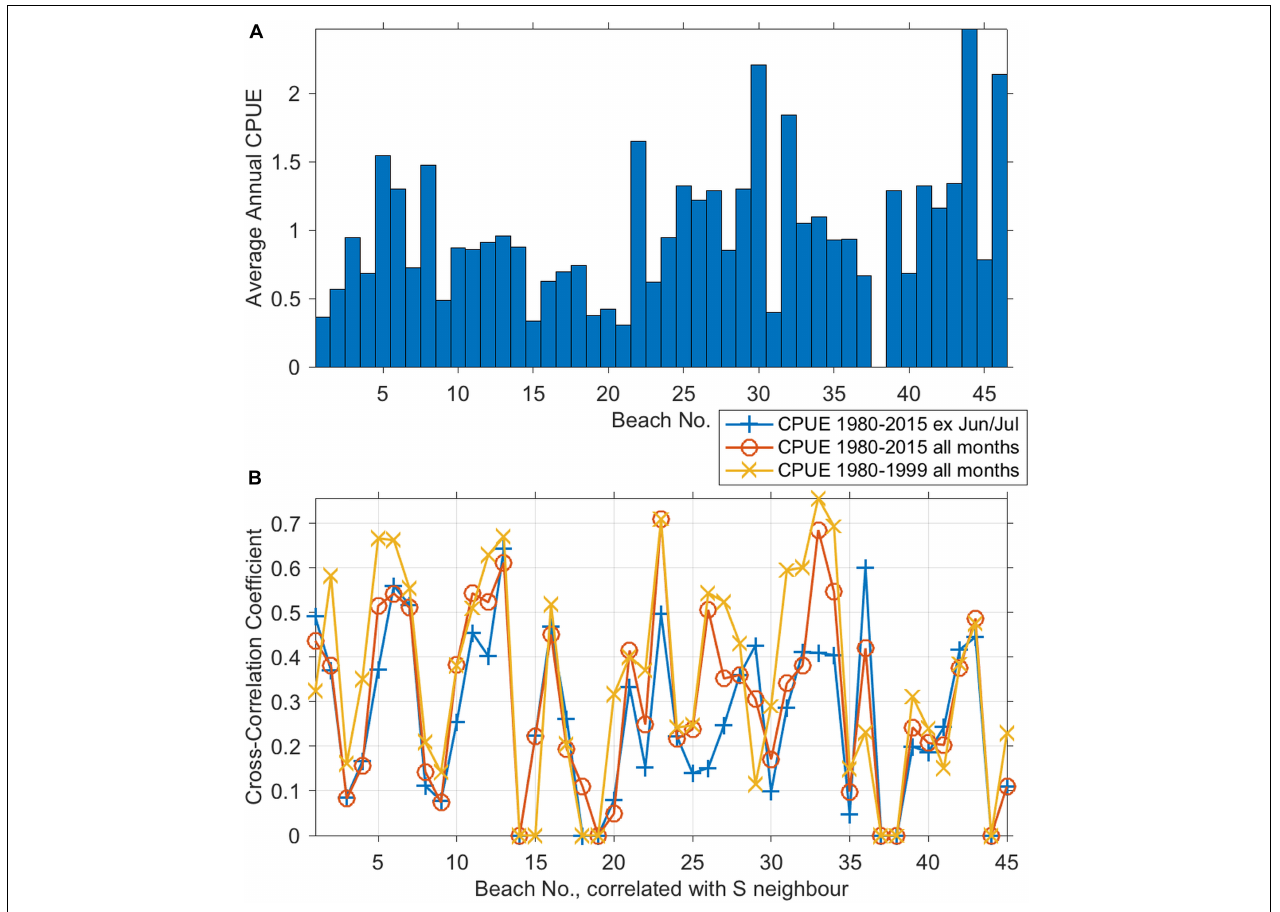
FIGURE 3 | Average 12-month CPUE by beach of T. aduncus , 1980–2015 (A) . Temporal cross-correlations of annual CPUE between beaches and their immediate neighbors to the South (B) . The three correlations were: for the 36 years excluding and including the peak Sardine Run months of June and July, and for the years < 1999 (i.e., prior to any deterrence devices on any